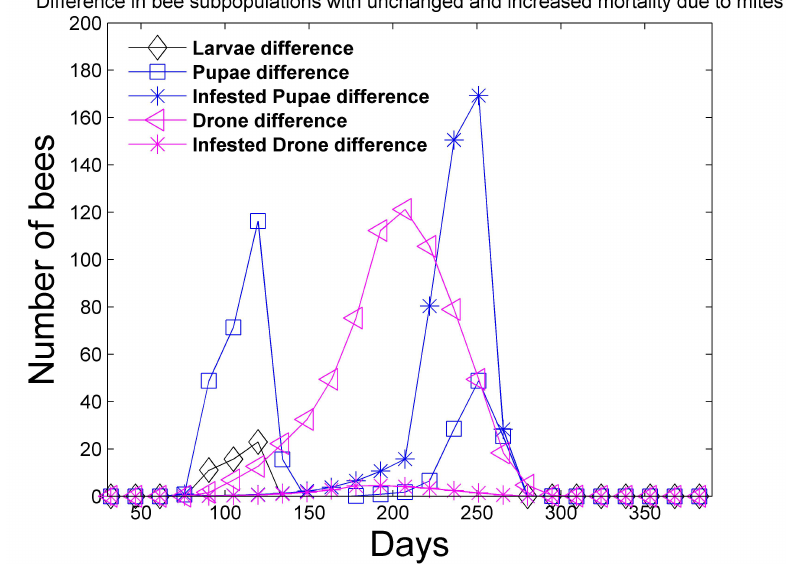
Figure 6. Two-year simulation of a honey bee colony with mites using the simulation parameters in Tables 4 and 5. Mites increase the mortality rates in Table 3 of infested pupae, hive, drone, and foragers by four times. Only the first year is shown since the colony does not survive past the first year. In this figure, the difference in the bee subpopulations (larvae, total pupae, infested pupae, total drones, infested drones) with unaffected mortality (Figures 1 and 2) and the bee subpopulations with increased mortality is